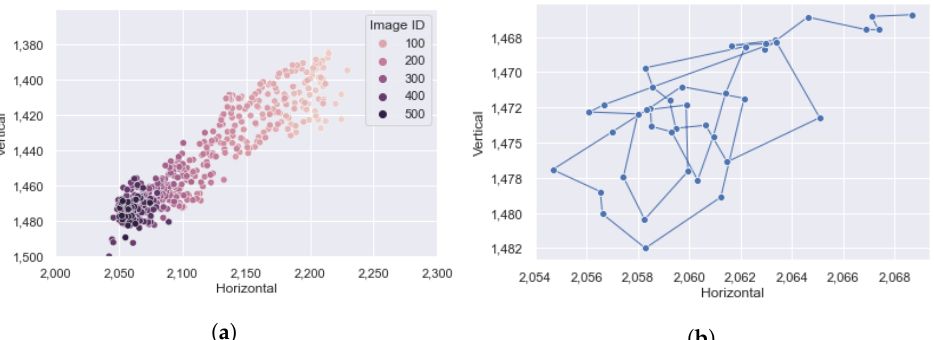
Figure 16. The positions of the target fruit, predicted by CROP . The coordinates are pixel numbers in the original image (Figure 11a), counting from the top-left corner. ( a ) All the positions were plotted including possible outliers inside and outside (to the below of) the range. The darker the color is, the later the image was captured. ( b ) Visualization of the movement during the five days: 8–12 October 2020.